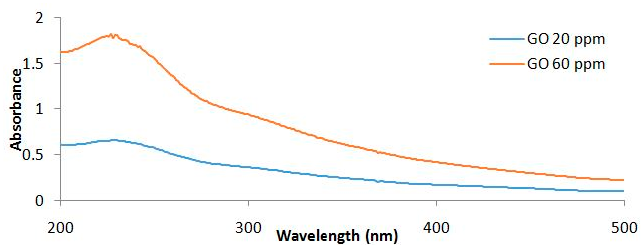
Figure A1. Fourier-transform infrared spectroscopy (FTIR) analysis of GONPs.